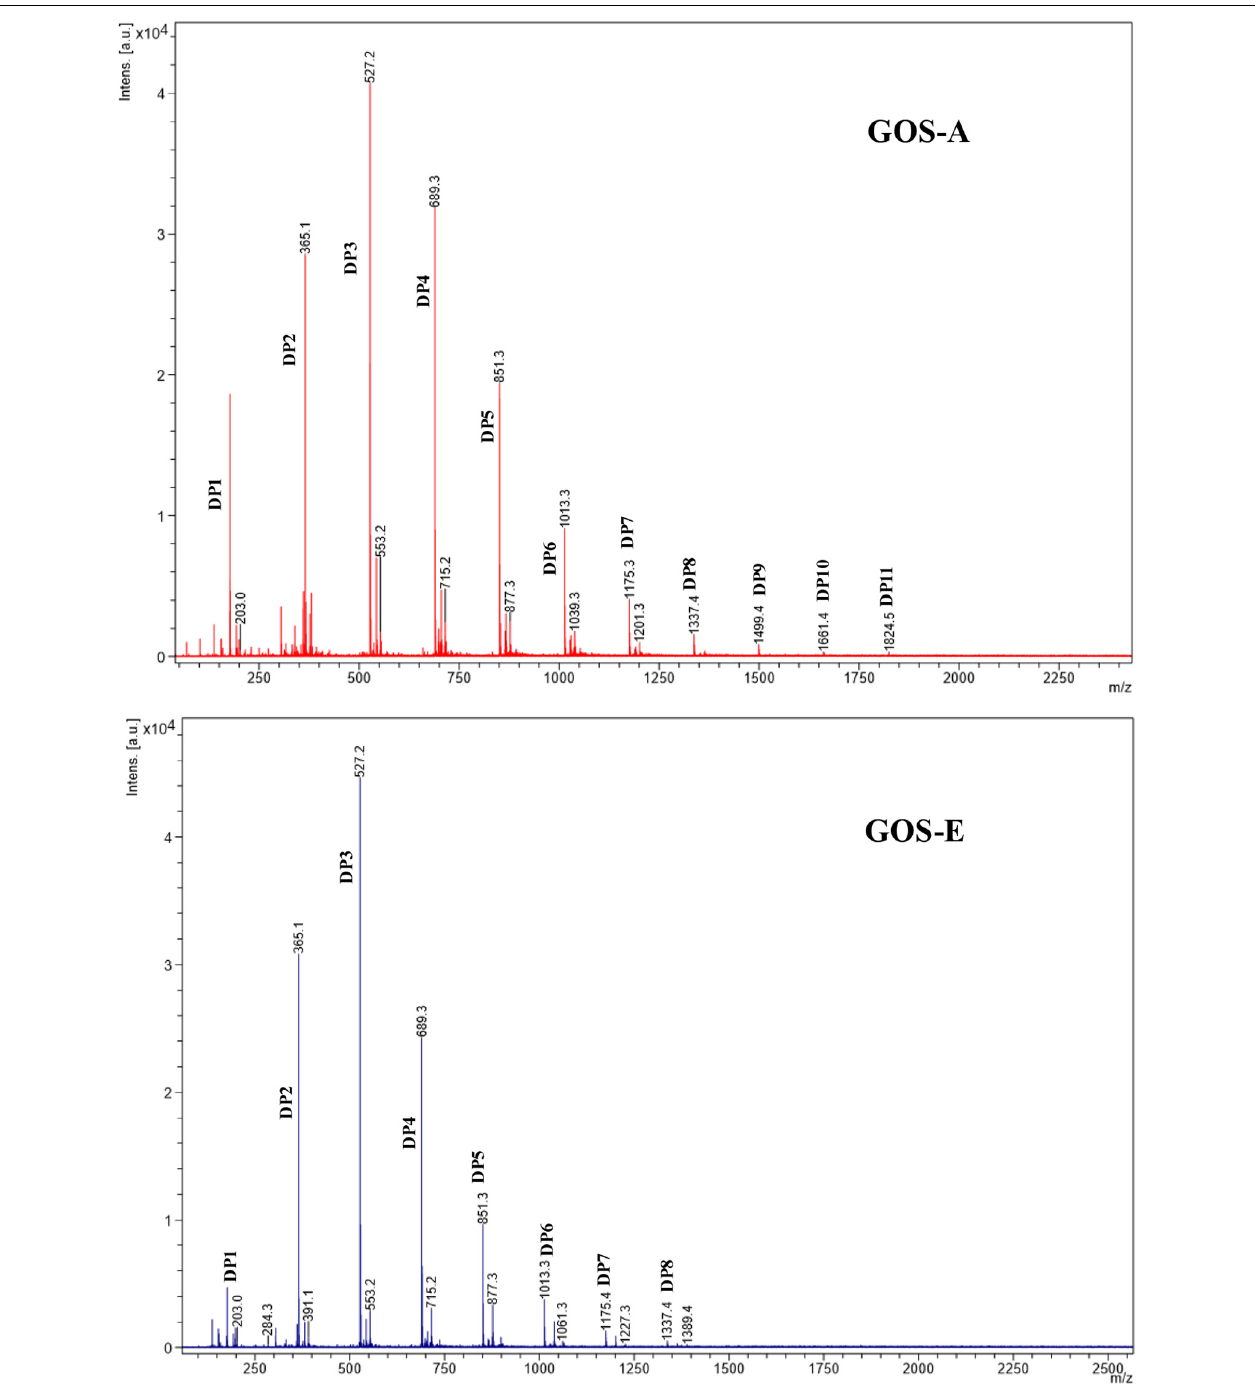
FIGURE 2 | MALDI-ToF mass spectra of GOS-A and GOS-E in the mass range m/z 700–2500. The Degree of Polymerization (DP) are assigned by the molecular weight (M) and their corresponding sodiated adducts [M + Na] + .